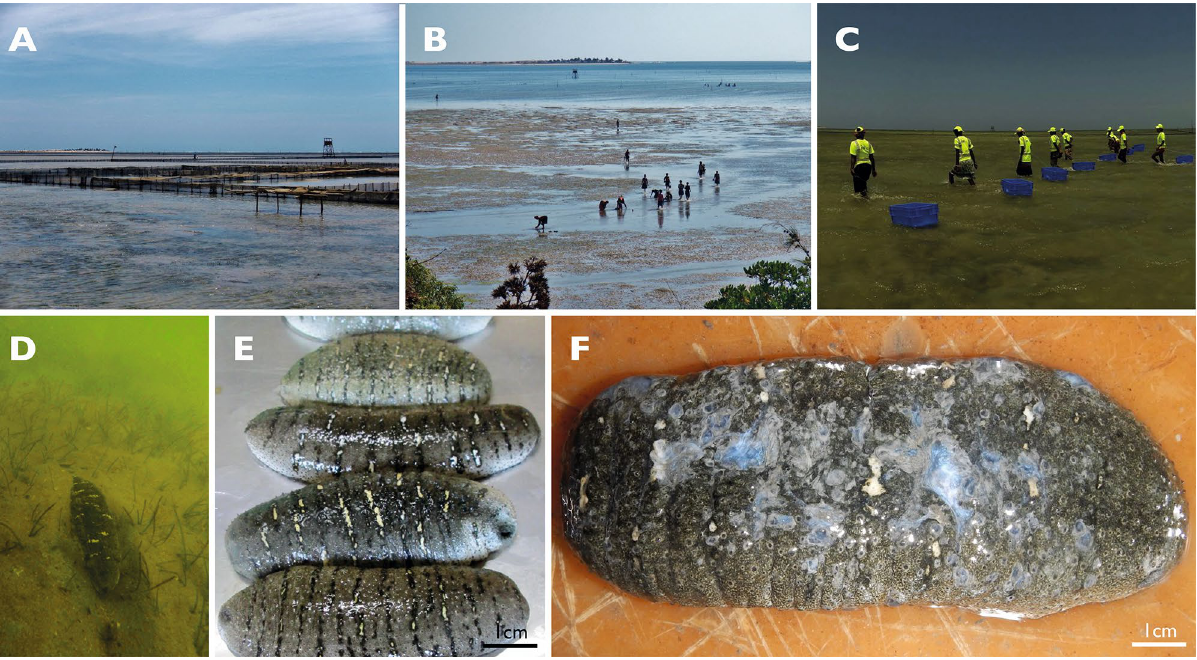
Figure 1. Holothuriculture in Toliara. ( A ) Pens from the company Indian Ocean Trepang at « La Mangrove » during low tide, ( B ) Collectors at « La Mangrove », ( C ) SKUD-affected collection at « La Mangrove », ( D ) H. scabra buried in the sediment, ( E ) Freshly collected sea cucumbers, ( F ) SKUD-affected sea